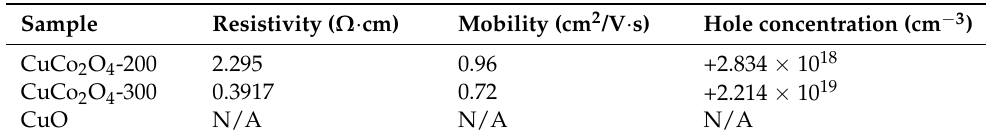
Table 1. Hall measurement results of the CuCo 2 O 4 at different annealing